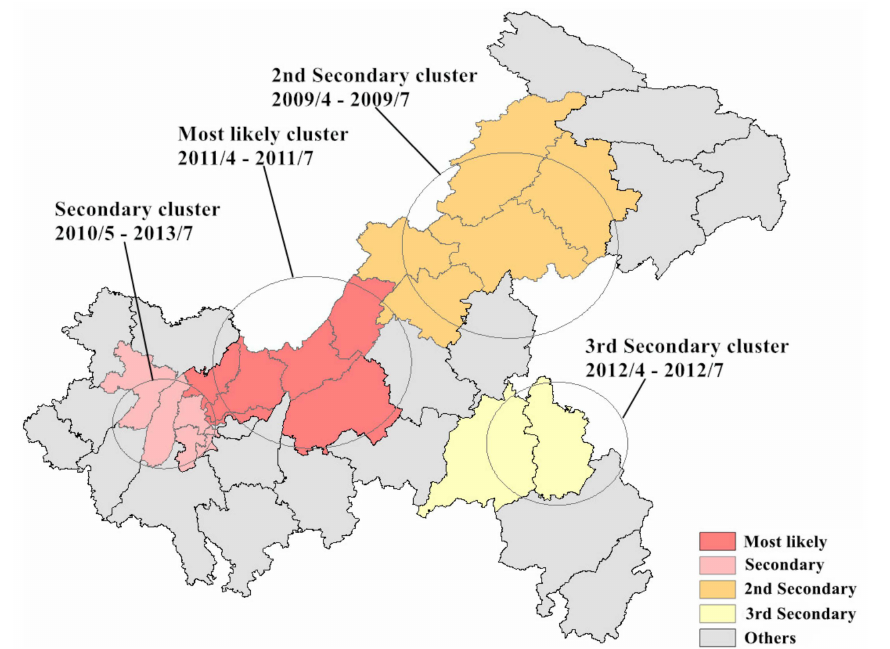
Figure 6. Spatiotemporal clusters of mumps in Chongqing from 2004 to